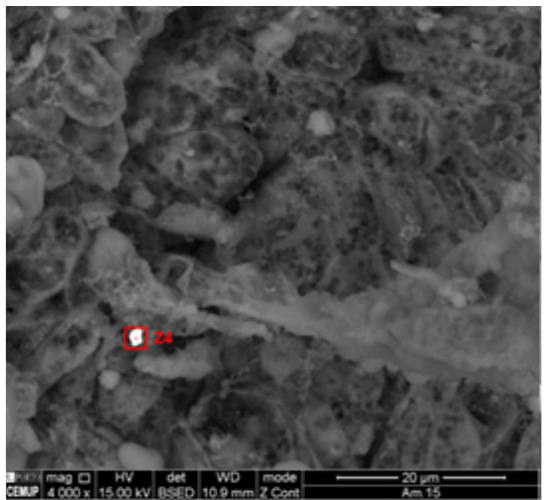
Figure 2B. Backscattered Electrons Image from Renal Tumor Tis- sue. Z4 Corresponds to the Zone where the Chemical Composition was Obtained by X-Ray Microanalysis. Magnification at 4000x.